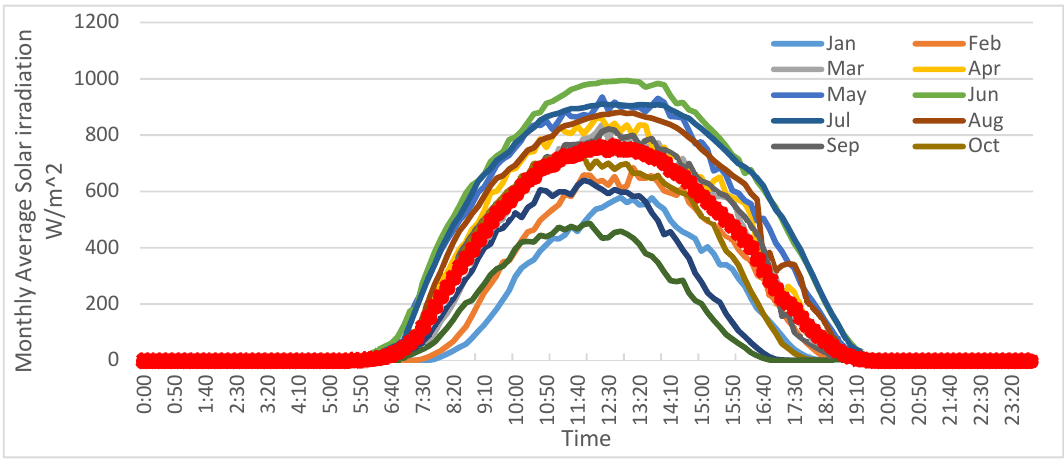
Figure 10. Daily average solar irradiation (W/m 2 ) [19,20].